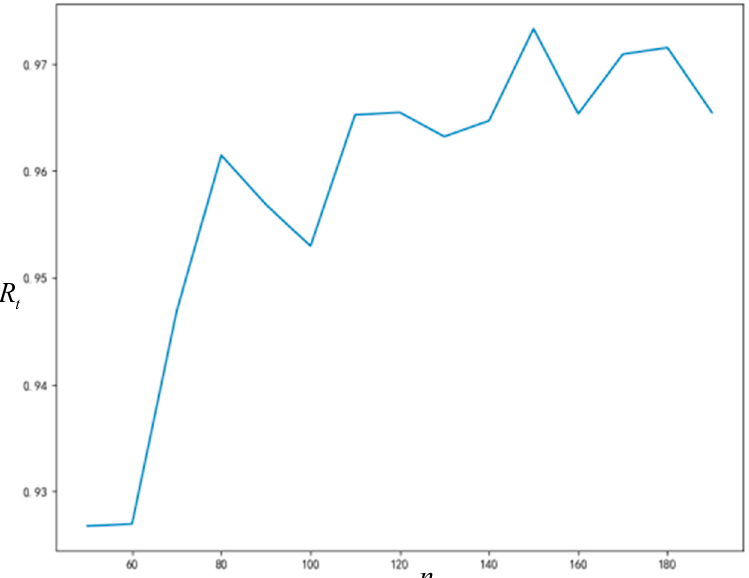
Figure 10. The relationship between node number and R t